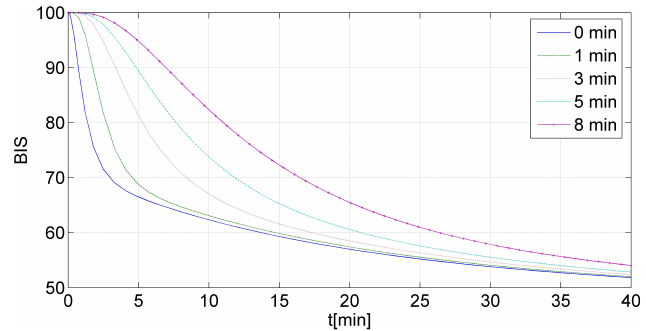
Figure 20. Patient response under different values of e ef f in the PK/PD